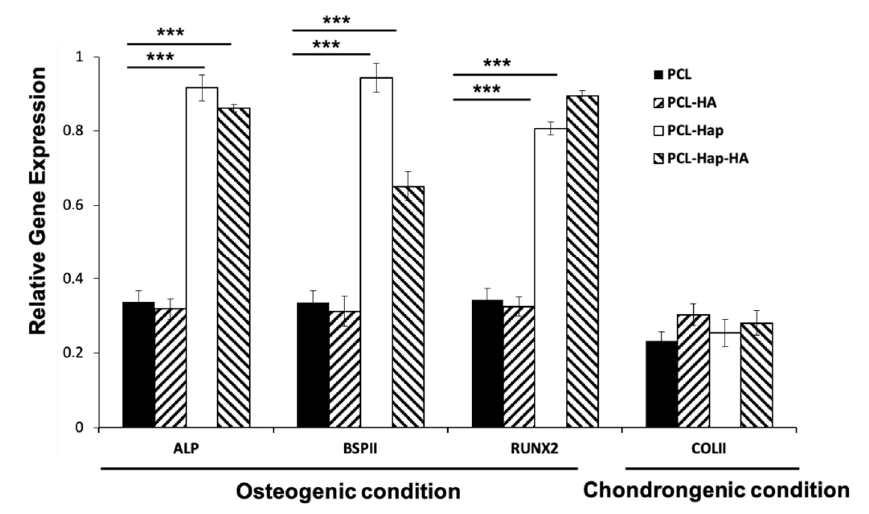
Figure 4. Relative gene expression of alkaline phosphatase (ALP), BSPII, RUNX2, and COLII genes in hBM-MSCs cultured for 7 days in osteogenic and chondrogenic conditions. *** p < 0.01 as compared to PCL.